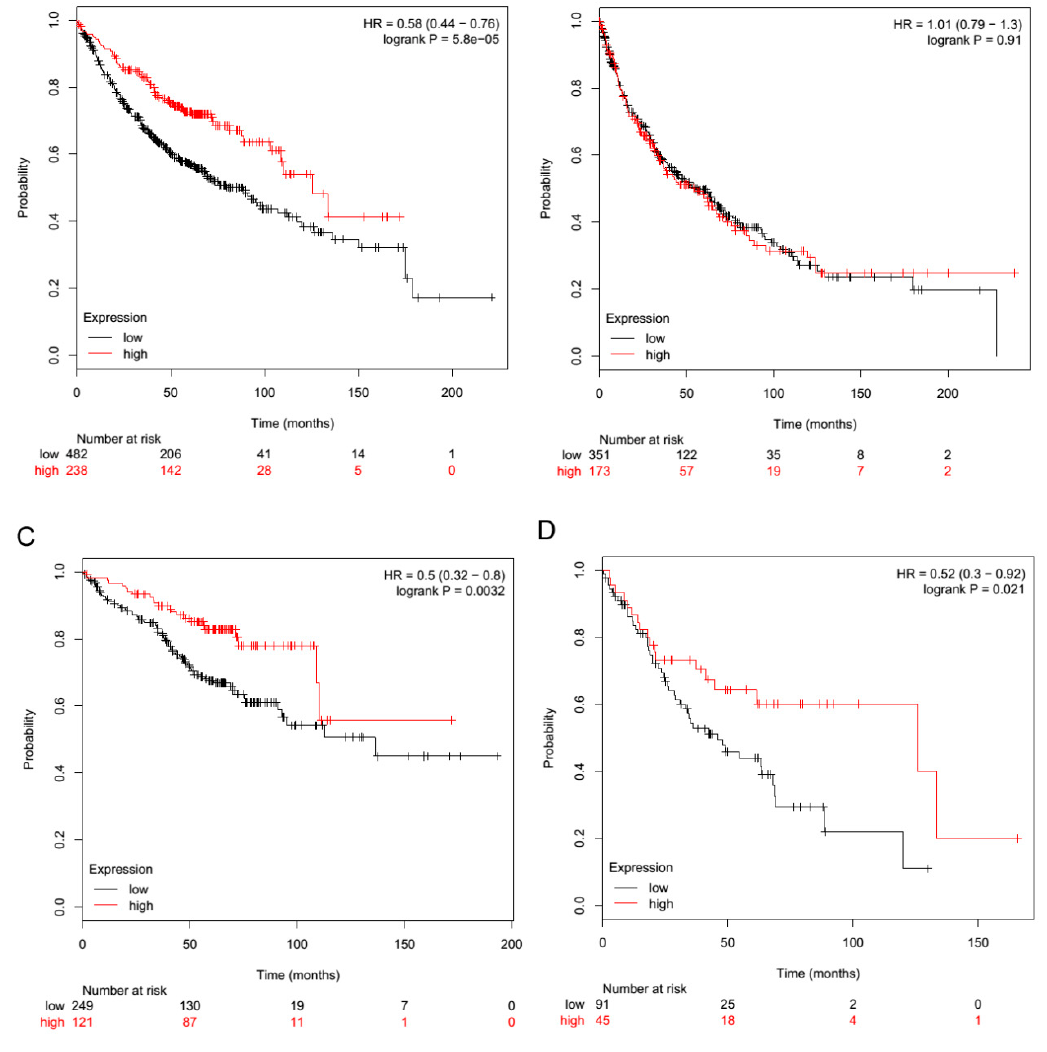
Figure 4. TLR3 mRNA expression is associated with a good prognosis in adenocarcinoma NSCLC. The relationship between TLR3 expression and prognosis was examined in the KM-Plotter public gene expression NSCLC datasets [19]. NSCLC patients were stratified by tertiles with regard to TLR3 mRNA expression (probe ID 206271_at). Red line: high TLR3 expression; black line: low TLR3 expression. ( A ) Overall survival probability of patients by TLR3 mRNA levels in adenocarcinoma NSCLC cases, n = 720. ( B ) Overall survival probability of patients by TLR3 mRNA levels in squamous NSCLC cases, n = 524. ( C ) Overall survival probability of patients by TLR3 mRNA levels in only stage I adenocarcinoma NSCLC cases, n = 370. ( D ) Overall survival probability of patients by TLR3 mRNA levels in only stage II adenocarcinoma NSCLC cases, n = 136.